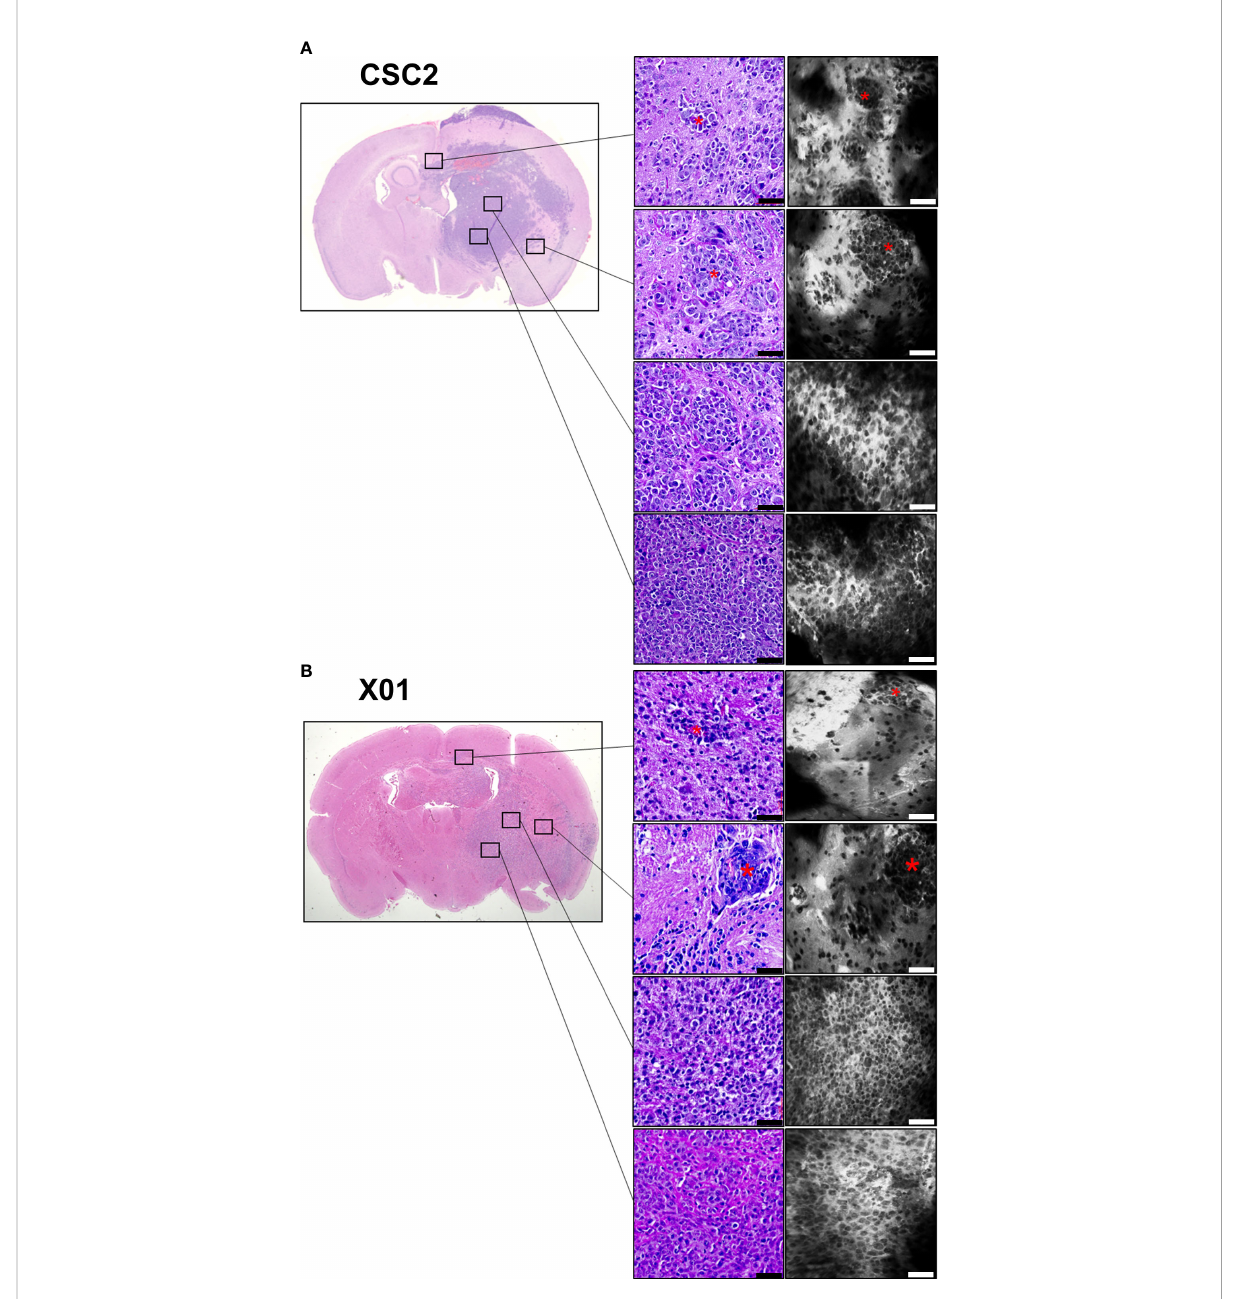
FIGURE 3 Photomicrographs in patient-derived orthotopic xenograft models. CSC2 (A) and X01 (B) patient-derived glioma stem-like cells (1 × 10 5 ) were injected into BALB/c nude mouse brains. Six weeks later, the mouse brain was obtained and incubated with indocyanine green fl uorescent dye. CLE images and H&E staining of the same tissues demonstrated two different glioma tissue cores and peripheral tumor margins, respectively. Asterix: Invasive cells. Scale bar: 50 µm. H&E, hematoxylin and